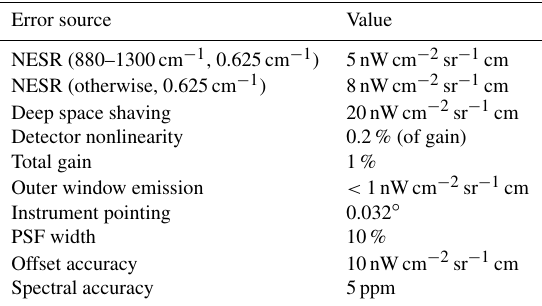
Figure 18. Uncertainty in gain magnitude. The plot depicts the stan- dard deviation computed over the individual gain magnitudes from all calibration times of the given flights in the WISE